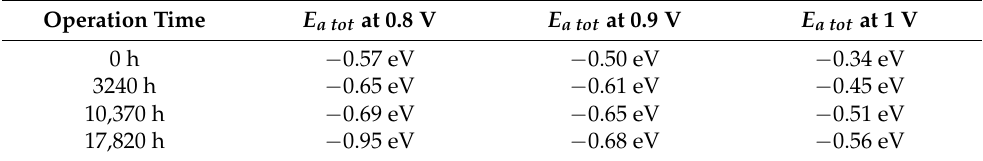
Figure 4. i-E curves of the SOFC durability test measured at the beginning and end of the experiment. Figure ( a ) shows the curves at different temperatures. Figure ( b ) presents the i-E curves measured at 650 °C and power density curves at the same conditions. Table 1. Total activation energies, E a tot , of the Ni-YSZ|YSZ|GDC|PSC fuel cell at different voltages and measurement